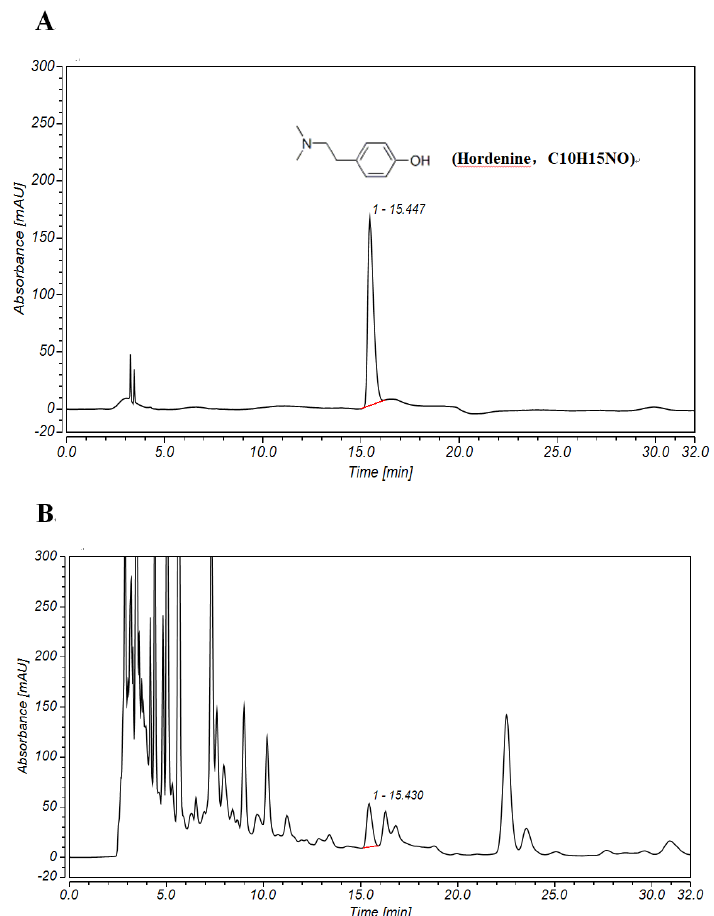
FIGURE 2 – The HPLC fingerprints of reference substance and malt samples: (A) hordenine; (B) 0.75 cm bud of barley